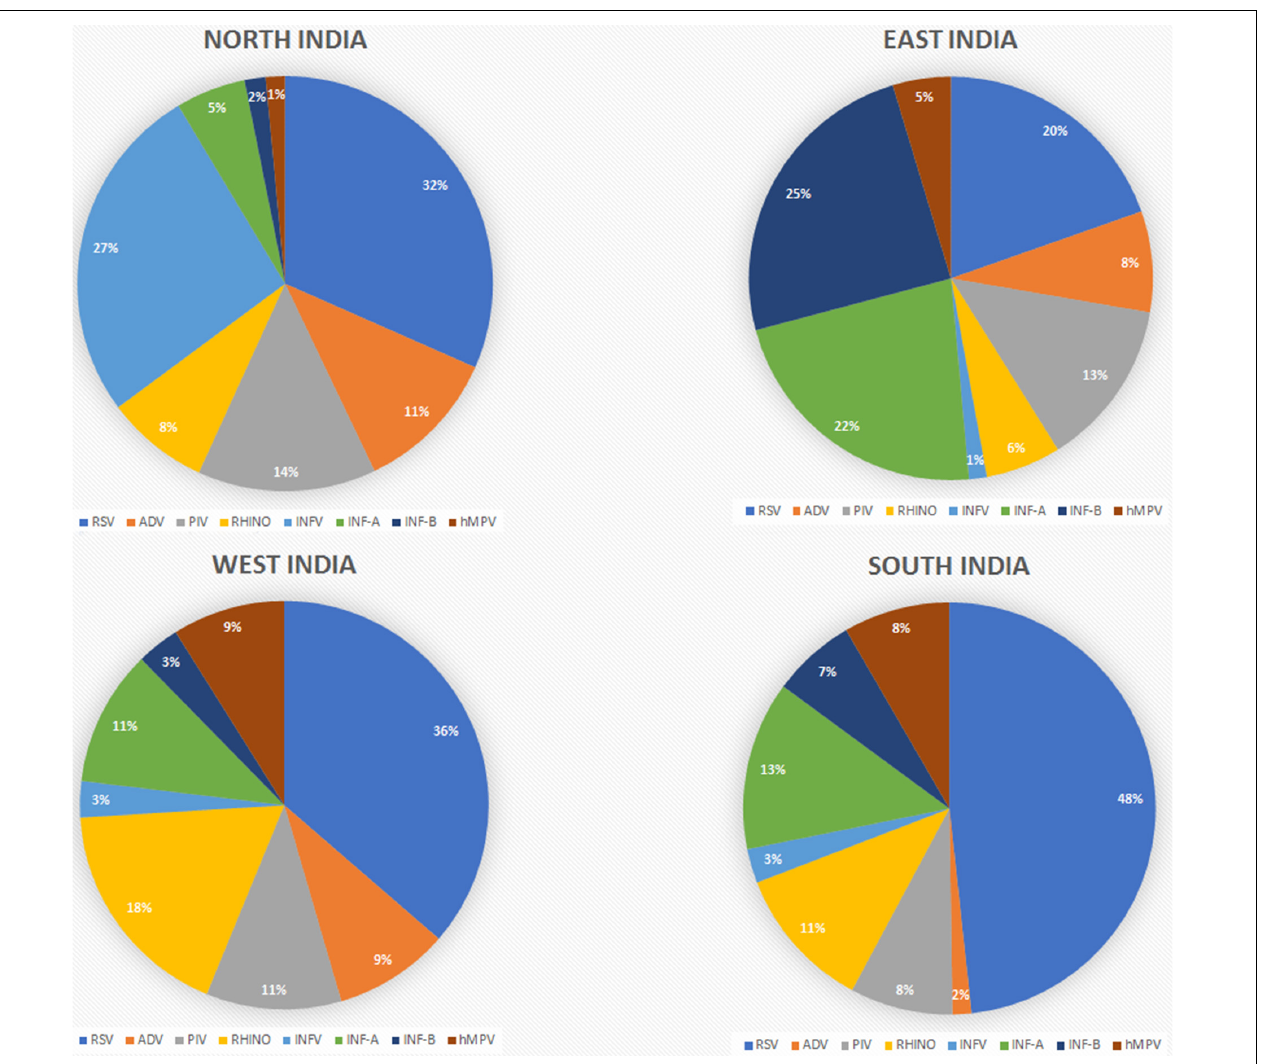
detected were RSV, which is higher than that in any other